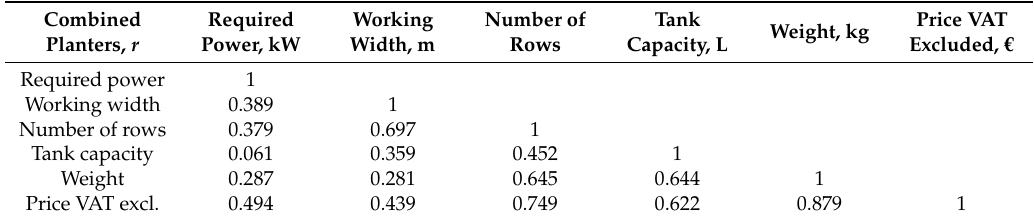
Table 5. Correlation matrix of Pearson coefficient r for functional parameters of combined planters.